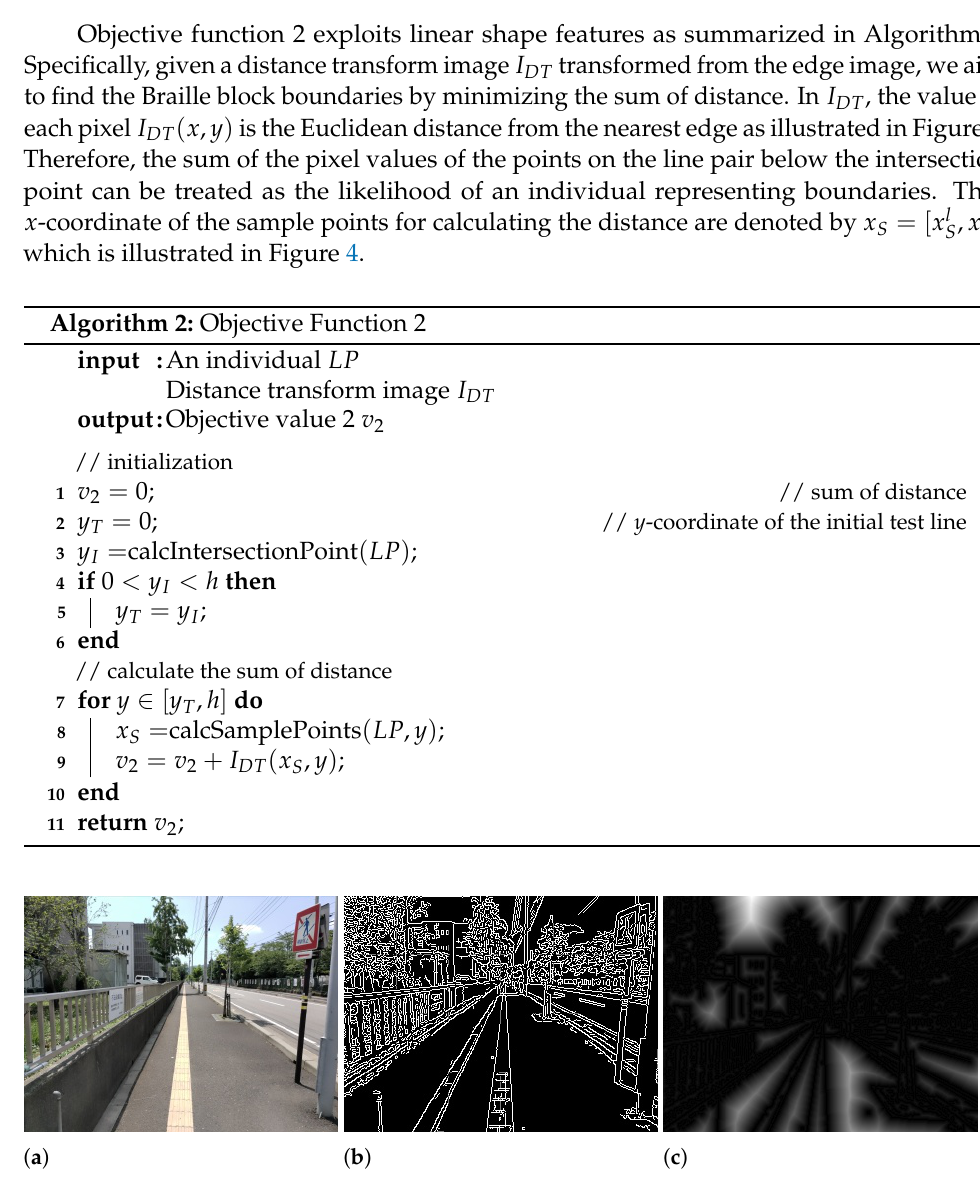
Figure 4. Test points in conditionB .